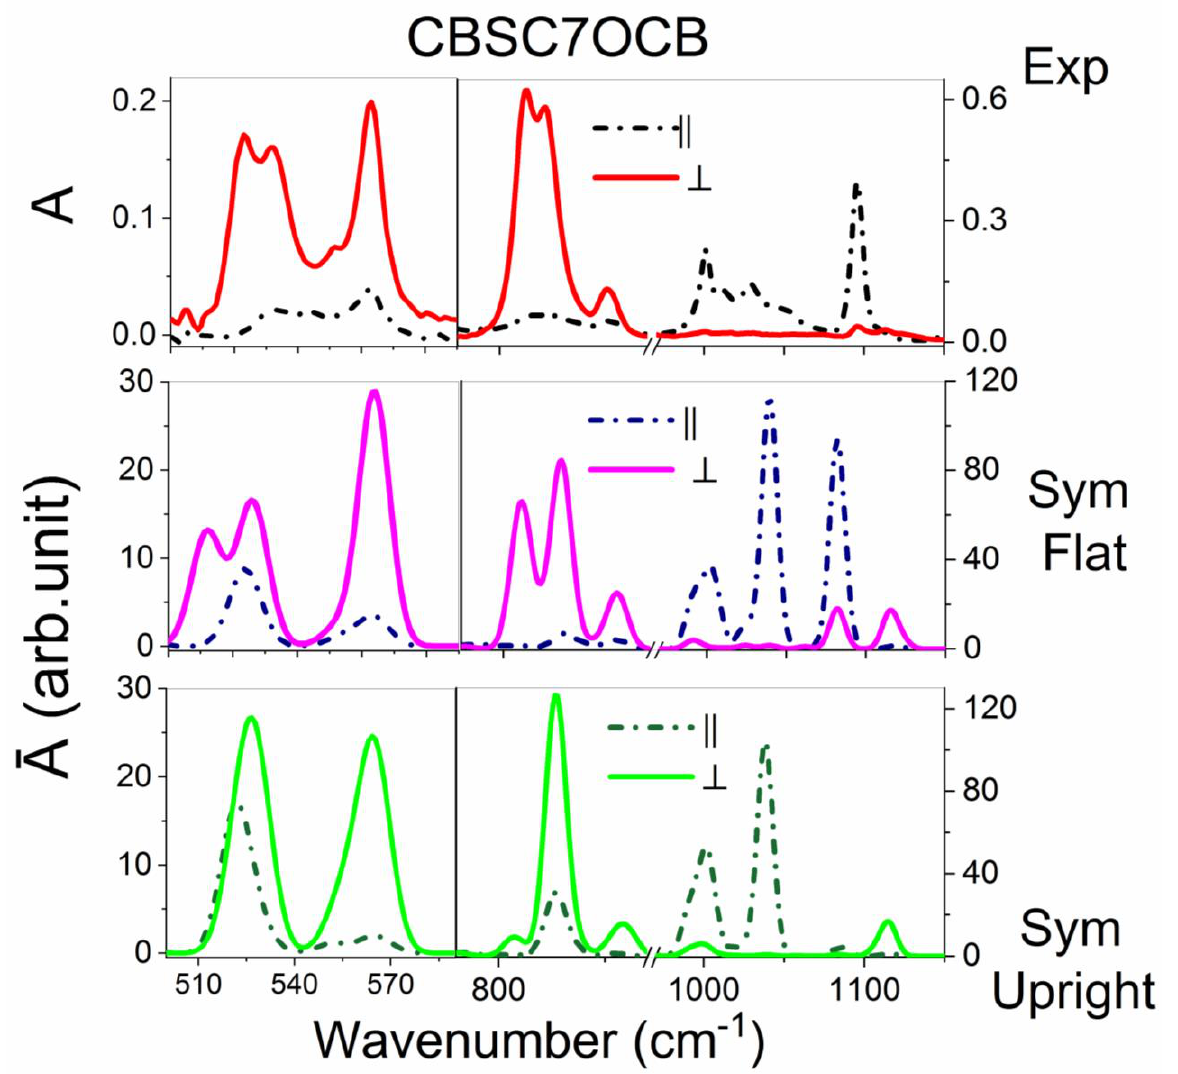
Figure 4. The comparison of the polarized experimental spectrum with the theoretical spectra (B3-LYP/6-311G (d,p)) for the CBSC7OCB dimer in the region of 500–1150 cm − 1 . A II – the parallel absorbance component in the z-axis direction of the molecular system, which coincided with the ordering axis of the sample. A ⏊ – the perpendicular absorbance component was perpendicular to the rubbing direction. Top Figures – experimental spectra of the nematic phase (375 K). Middle Figures – calcu- lated spectra for a flat conformer (dihedral angles C Al -S-C Ar -C Ar = 0°, C Al -O-C Ar -C Ar = 0°). Bottom Figures — calculated spectra for a mixed conformation (dihedral angles C Al -S-C Ar -C Ar = 90°, C Al -O- C Ar -C Ar = 0°).